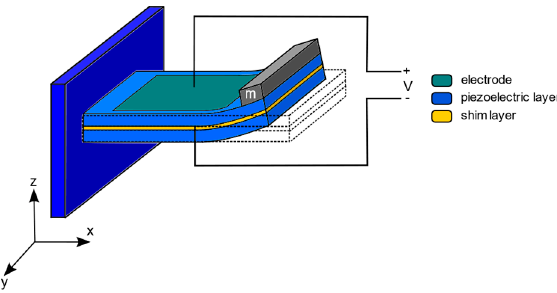
Figure 6. Piezoelectric kinetic harvester.